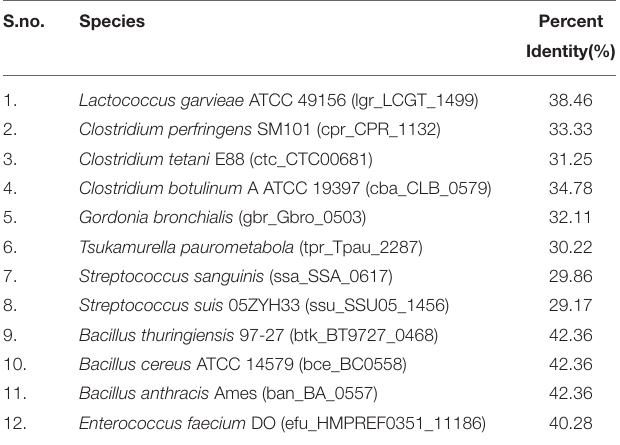
TABLE 2 | List of pathogens showing significant identity with NFeD domain harboring gene, bsu_BSU31020 of B. subtilis.